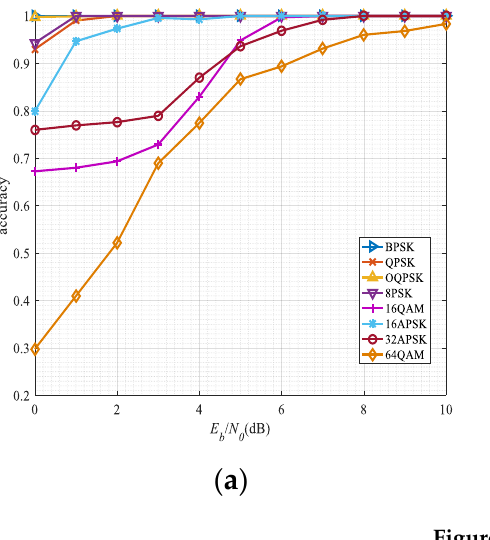
Figure 13. Conts.